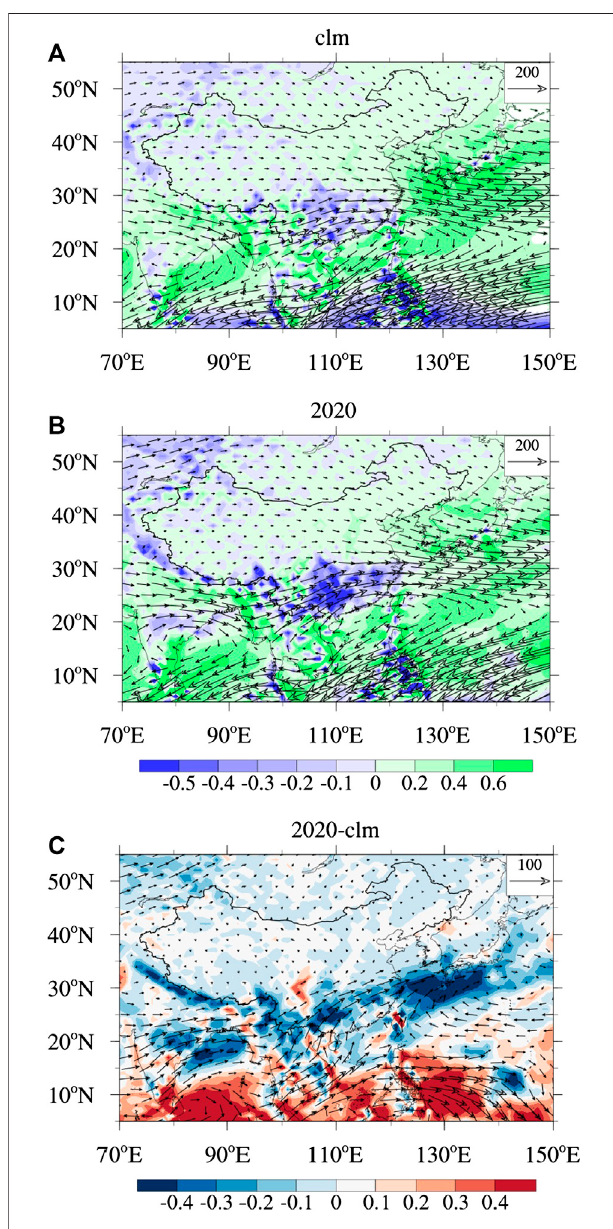
FIGURE3| ThespatialdistributionsoftheverticallyintegratedDJFmean moisture fl ux (vector, units: kgm 1 s − 1 ) and the corresponding average divergence (shading, units: 10 − 4 kgm − 2 s − 1 ) for (A) climatological